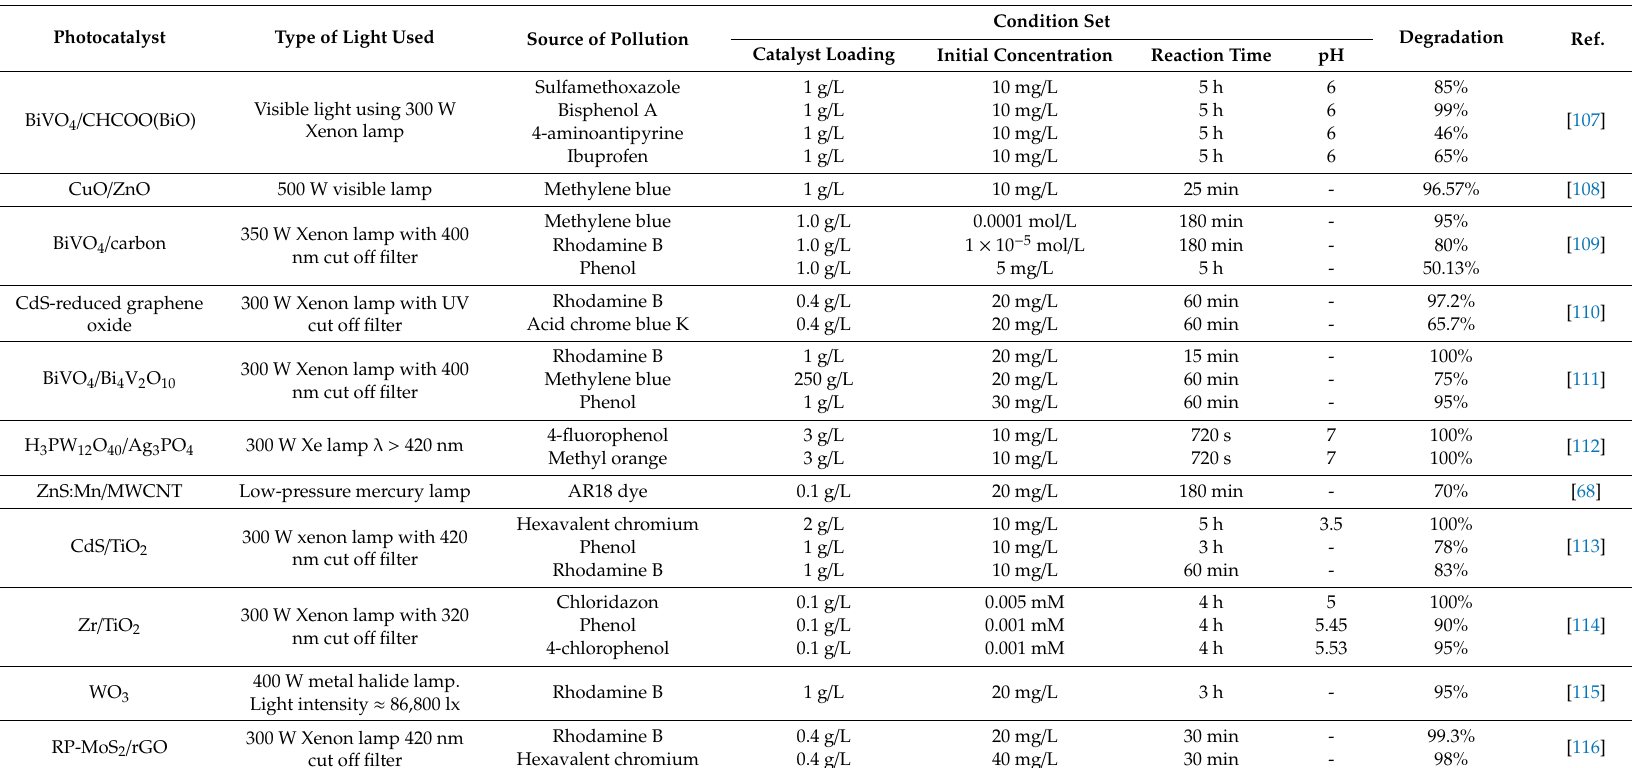
Table 4. Example of a current study of the photocatalyst in degradation from a di ff erent source of organic